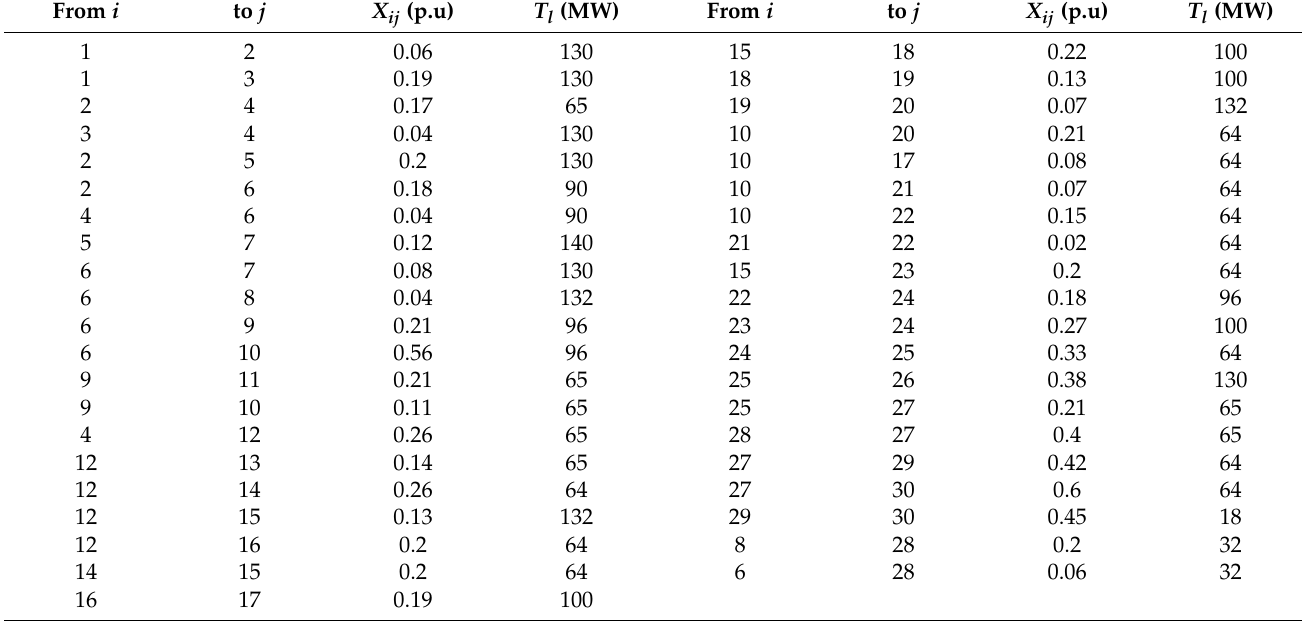
Table 3. Transmission line characteristics in IEEE 30 bus power